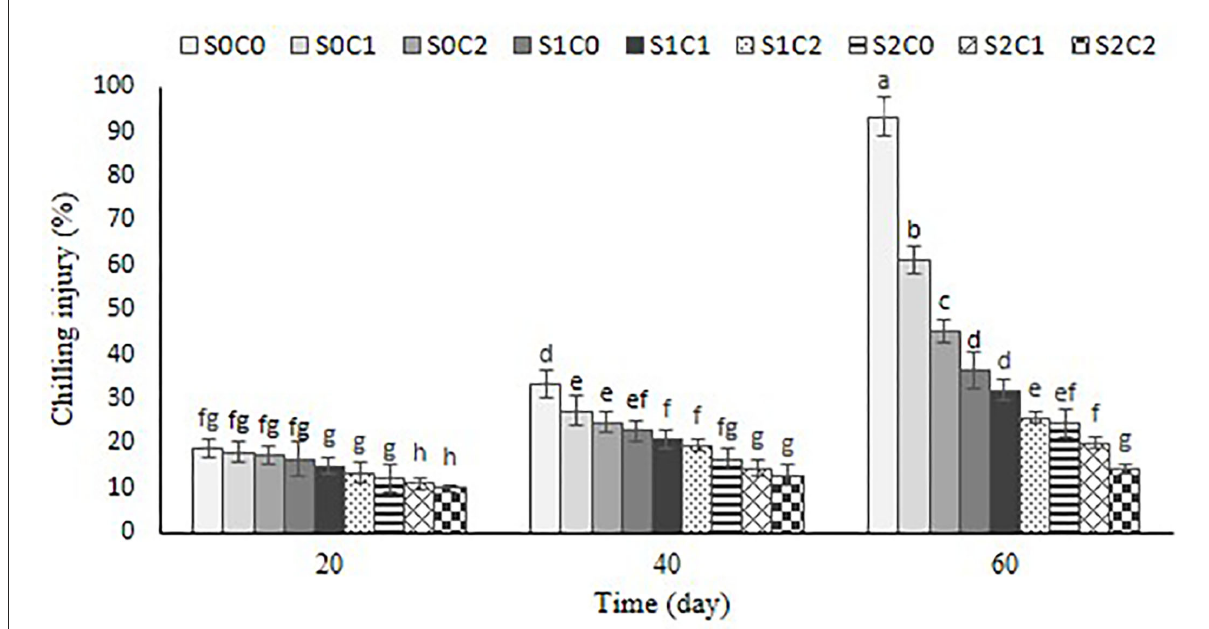
FIGURE3 Effect of foliar spraying of SA and caraway oil coating on chilling injury percentage during 60 d of storage at 4 ± 2 ◦ C plus shelf life (2 d, 20 ◦ C). S0C0: control, S0C 1 : 0.3% caraway oil, S0C 2 : 0.6% caraway oil, S1C0: 1.5mM Salicylic acid, S1C1: 1.5mM Salicylic acid + 0.3% caraway oil, S1C2: 1.5mM Salicylic acid + 0.6% caraway oil, S2C0: 3mM Salicylic acid, S2C1: 3mM Salicylic acid + 0.3% caraway oil, S2C2: 3mM Salicylic acid